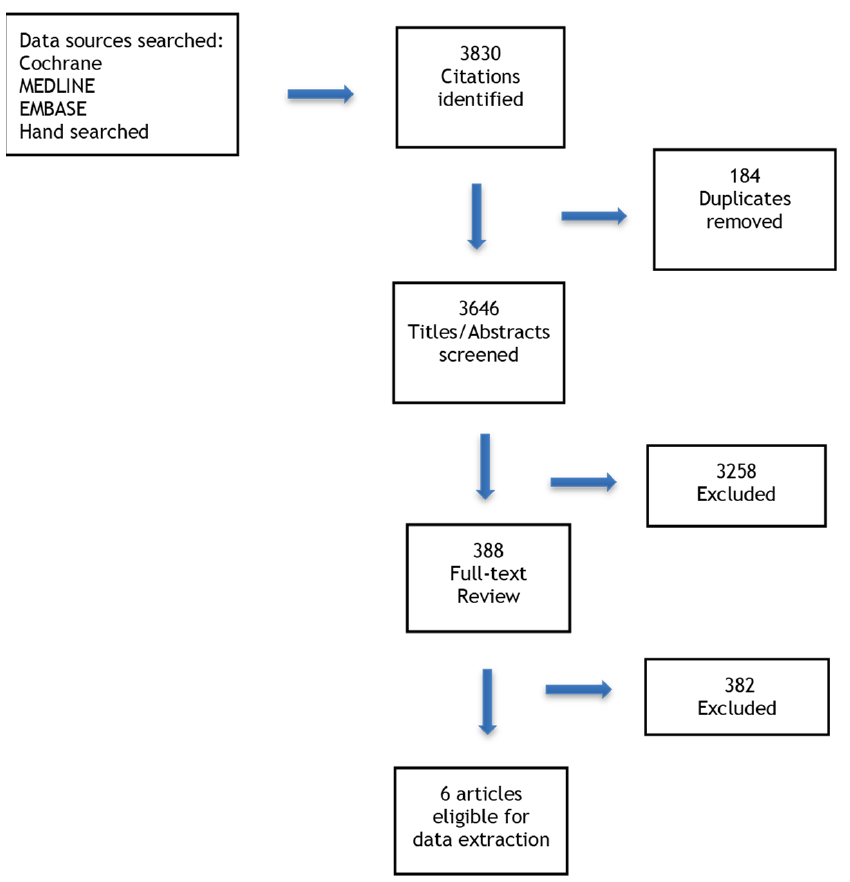
Figure A1. Primary literature results plus updated search results.